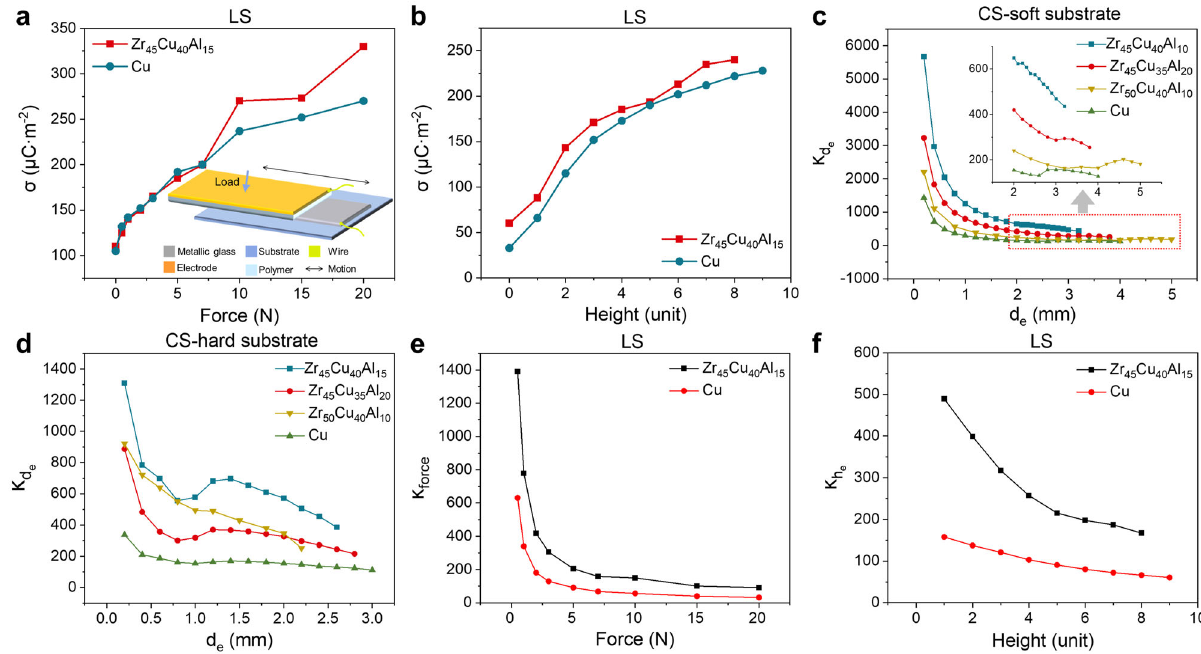
Fig.3|Resultsoftriboelectri fi cationef fi ciency. SurfacechargedensityofLSmodeTENGversus a forceand b height. c κ d of CS mode TENG under hard substrate. e κ force and f κ h